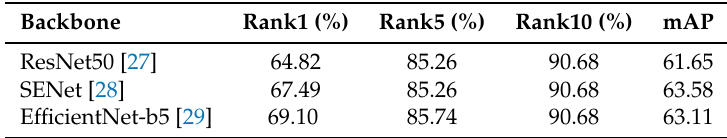
Table 2. Top results of proposed methods at Rank 1, 5, 10, and mean average precision (mAP) on MVB dataset.